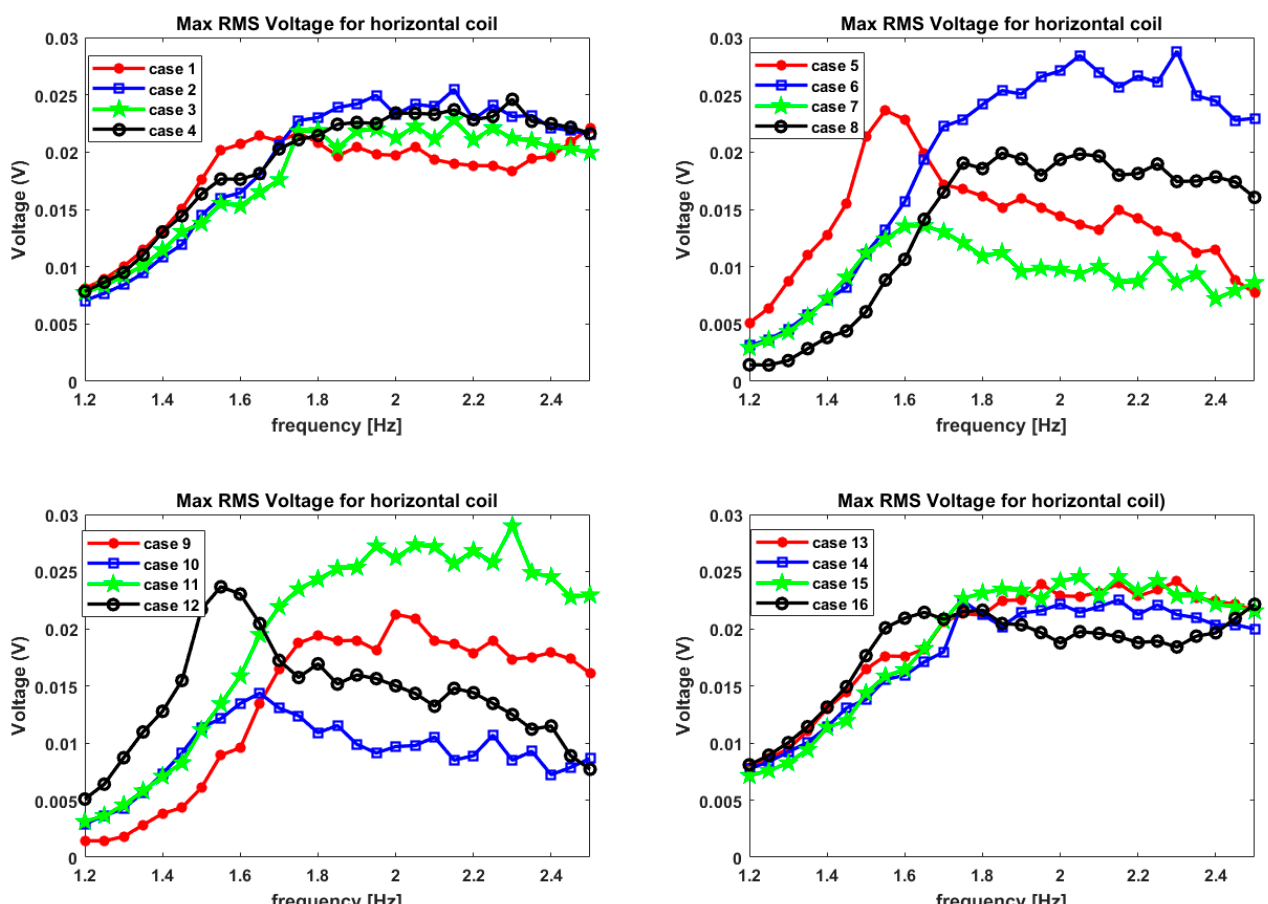
Figure 11. RMS voltage plots for Cases 1–16 while considering horizontally wound coil for L = 10 cm tank.